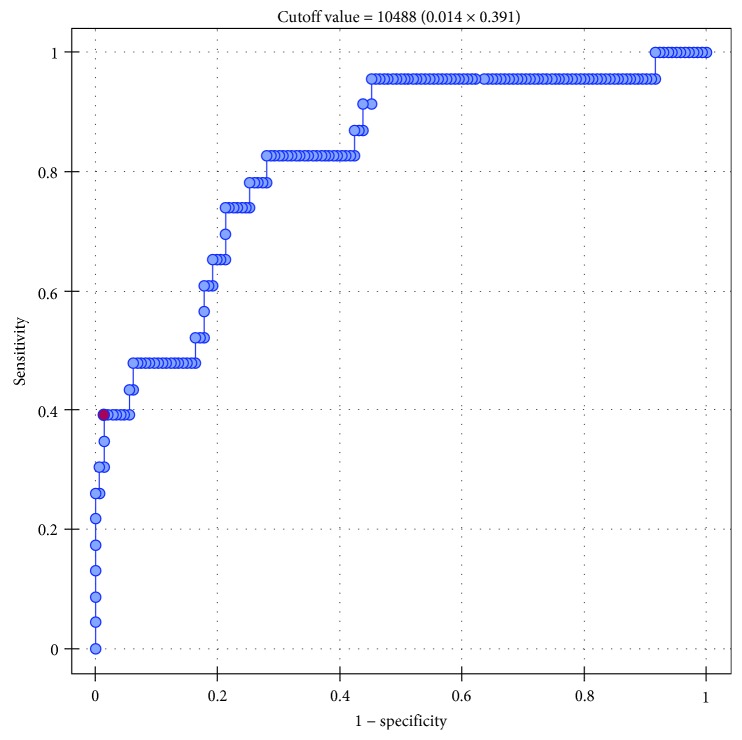
ROC curve—relationship between sFlt-1 concentrations (pg/ml) and occurrence of preeclampsia (AUC 82.4%).